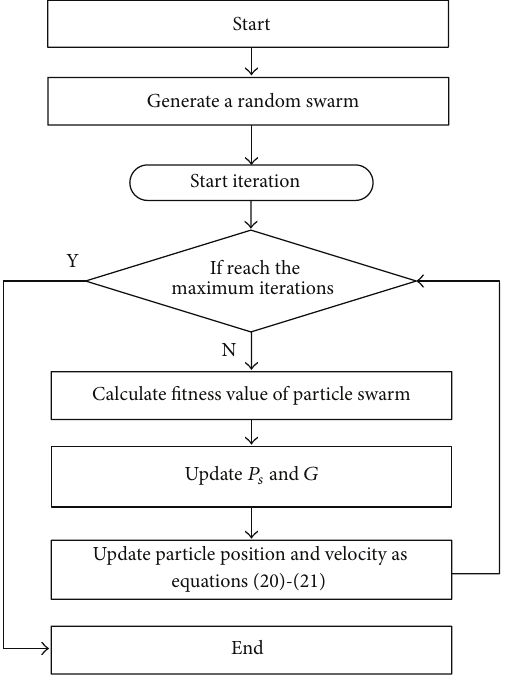
Figure 1: Flow chart of general